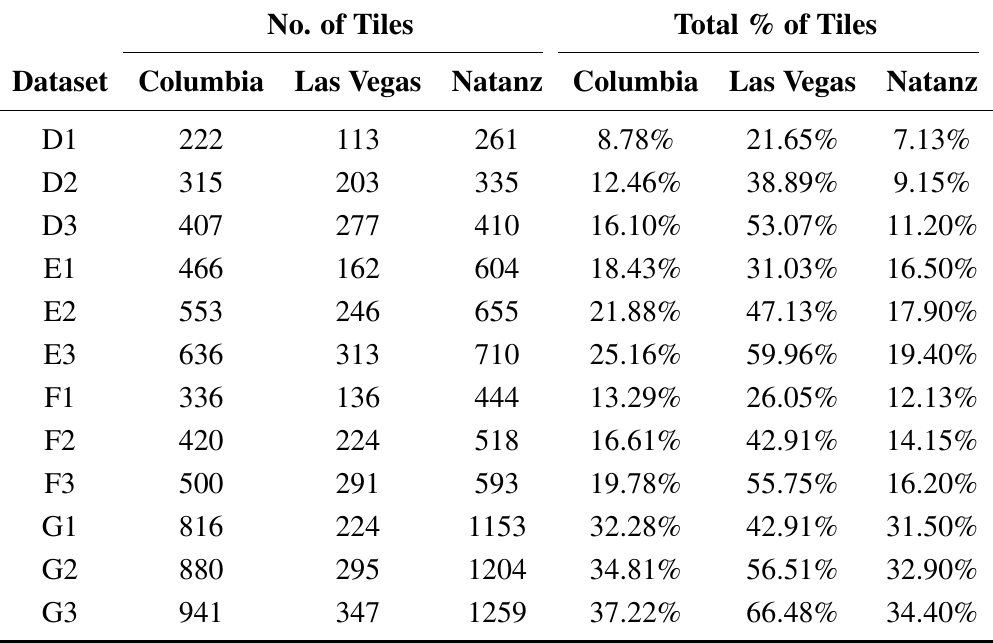
Table 7. This table provides more detailed information on the composition of the training datasets introduced in Table